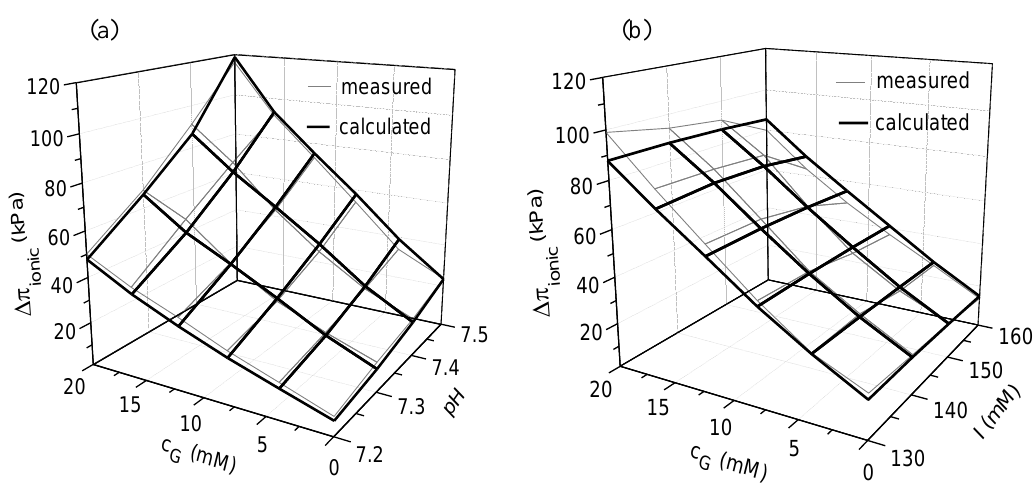
Figure 3. Ionic component ∆π of the gel swelling pressure measured by means of the ionic sensor 1 with AAm/3-AAmPBA/BIS hydrogel at 36.5 °C in PBS solutions (ionic strength I = 0.15 M) plotted over the glucose concentration c and pH ( a ) and in PBS solutions G (pH7.4) plotted over the glucose concentration c and ionic strength I ( b ) as well as G corresponding calculated values of ∆π . The values of a , b, and λ used for the ionic 1 calculation are shown in Tables C3 and C4 (Appendix